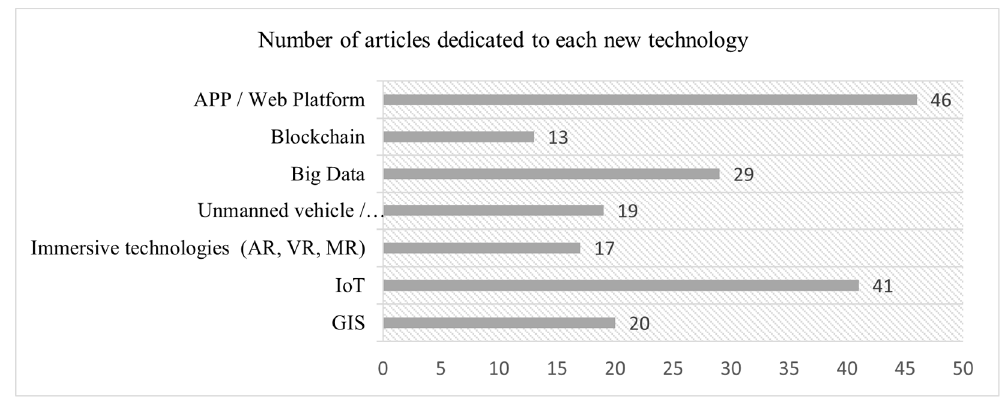
Figure 5. Number of articles dedicated to each new technology.